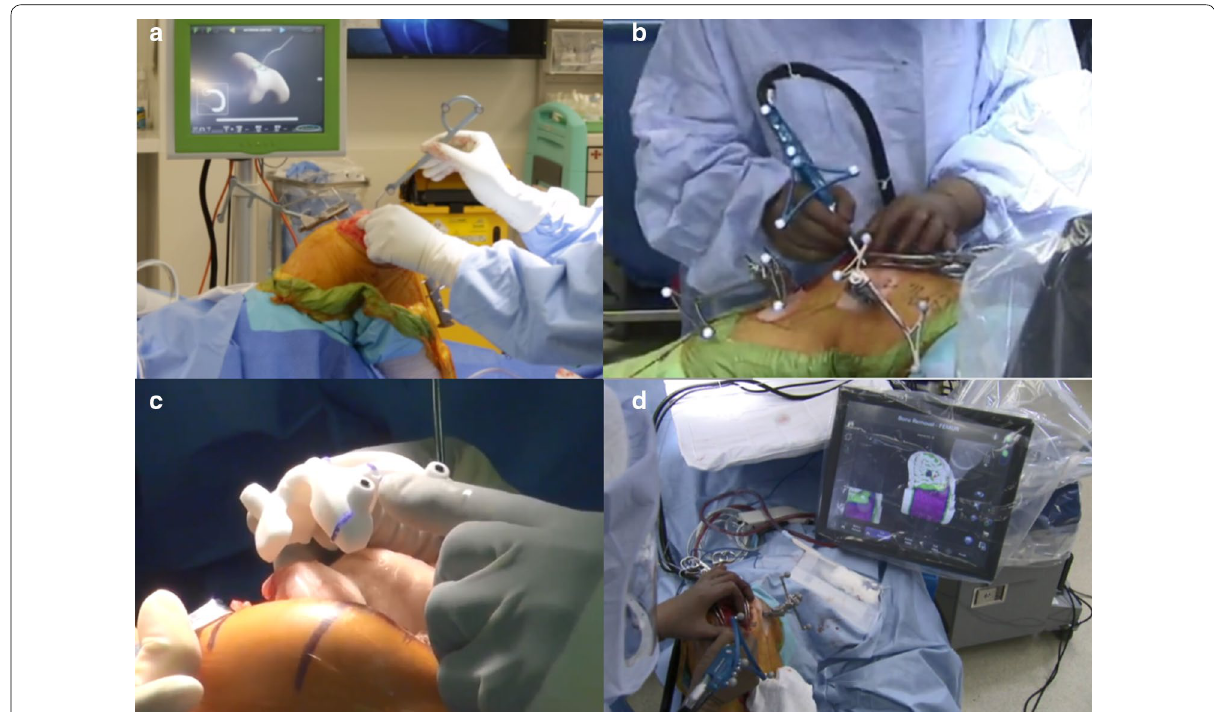
Fig. 5 a Computer Navigation, b , d Robotic-assisted UKA, c Patient-specific instrumentation